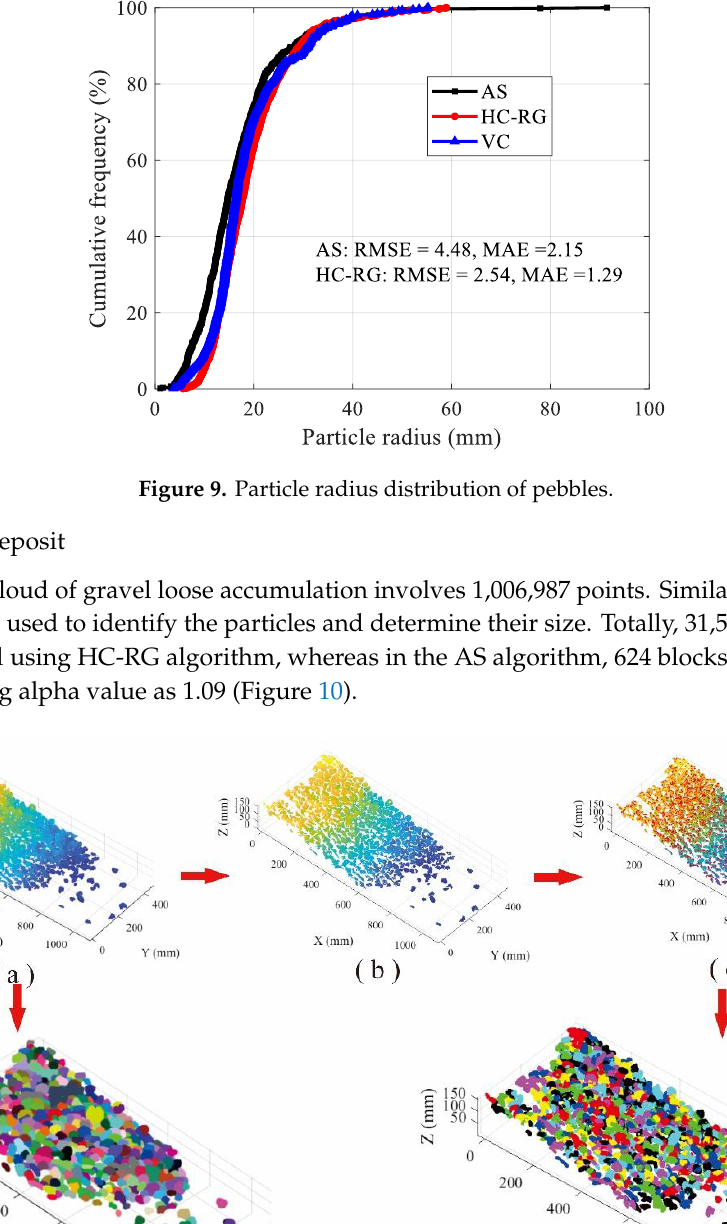
Figure 8. Comparison of recognition performance of pebble loose accumulation: ( a ) point cloud, ( b ) separation processing, ( c ) peak points of each block region, ( d ) recognition using HC-RG algorithm, and ( e ) recognition using AS algorithm.